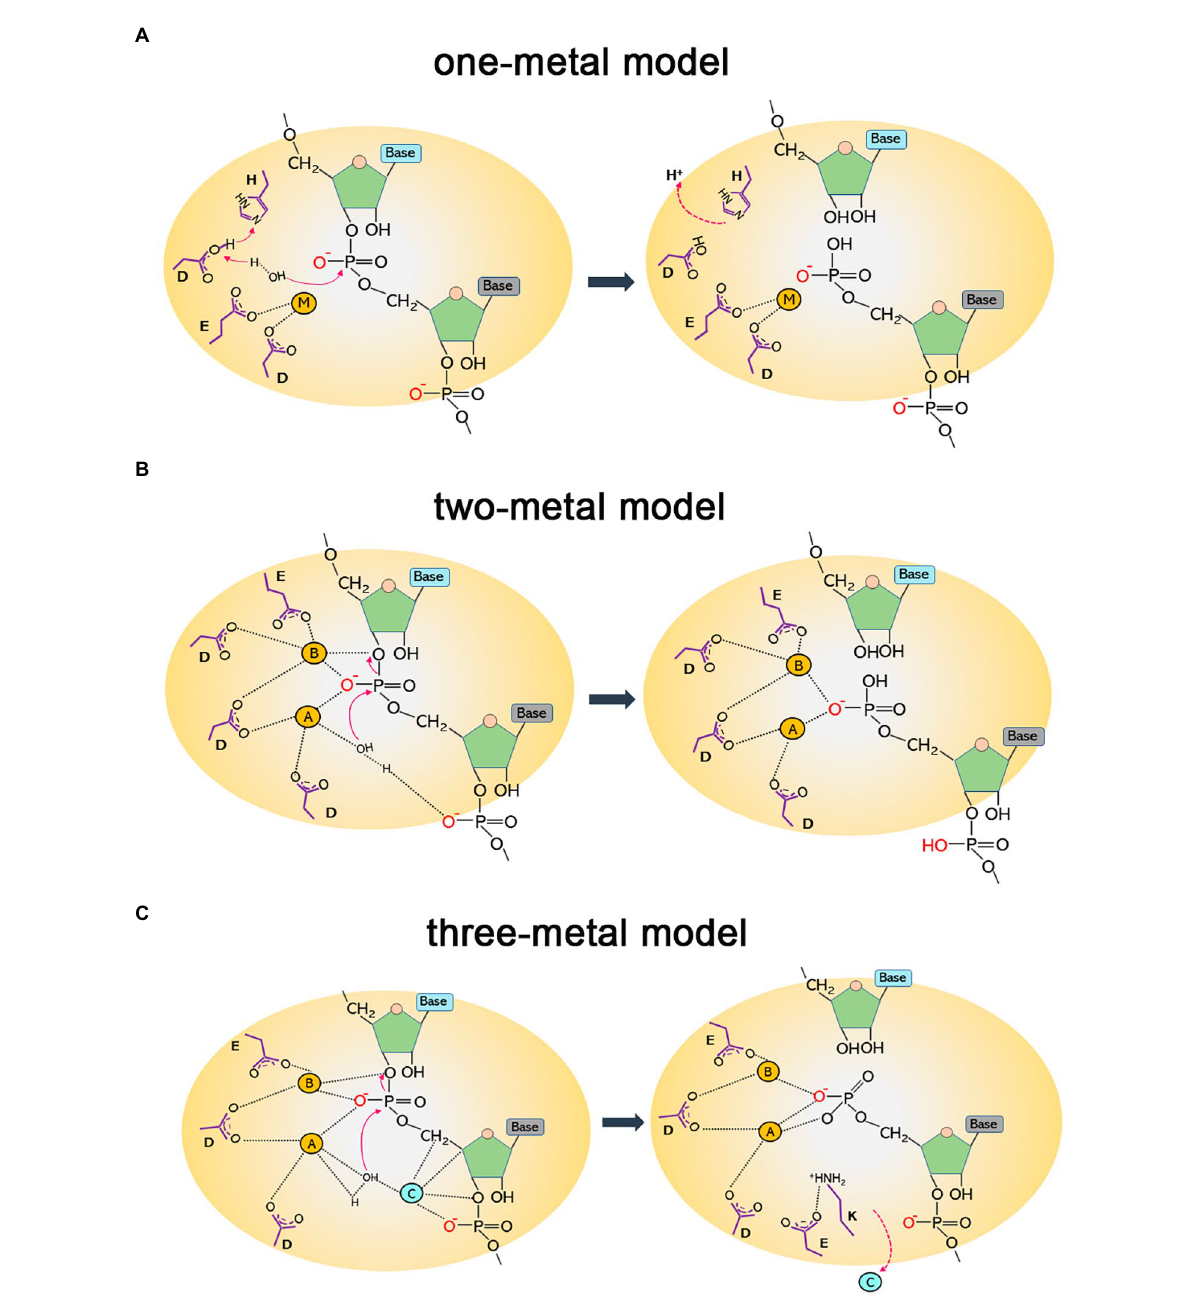
FIGURE 1 Diagrams of catalytic mechanisms of RNases H. (A) One-metal model. The imidazole group of a histidine residue promotes the deprotonation of the acidic side chain of an aspartate, which further deprotonates a water molecule. The nucleophilic hydroxyl produced attacks the phosphodiester bond, leading to hydrolytic cleavage. The single metal ion (M) is bound to two conserved carboxylates (aspartate and glutamate) to stabilize a transition state intermediate. (B) Two-metal model. The hydrolysis of the P-O3 ′ bond relies on two metal ions. Metal ion A, coordinated by two aspartates, activates a water molecule to attack the scissile phosphate as a nucleophile; metal ion B is shared between an aspartate and a glutamate and facilitates the phosphoryl transfer reaction. (C) Three-metal model. Besides the two canonical metals that function as in the two-metal model, a third ion (C) is transiently bound to synergize with metal A and activate water for a nucleophilic attack. It departs immediately after cleavage. A conserved lysine may assist in aligning the substrate to capture transient cations for catalysis. It forms a salt bridge with a glutamate to facilitate the removal of cations and product